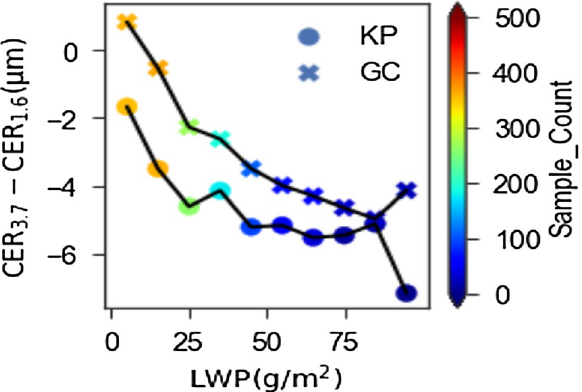
Figure 2. Differences between CERs at 3.7 and 1.6 µm for LWP bins of 10 g/m 2 spectrum for Kanpur (KP) and Gandhi College (GC)